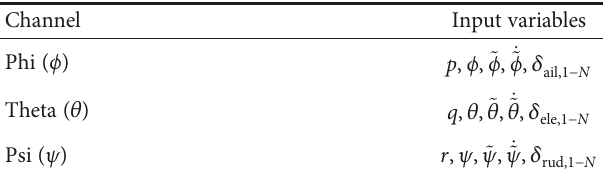
Table 3: Input variables of the neural network. Channel